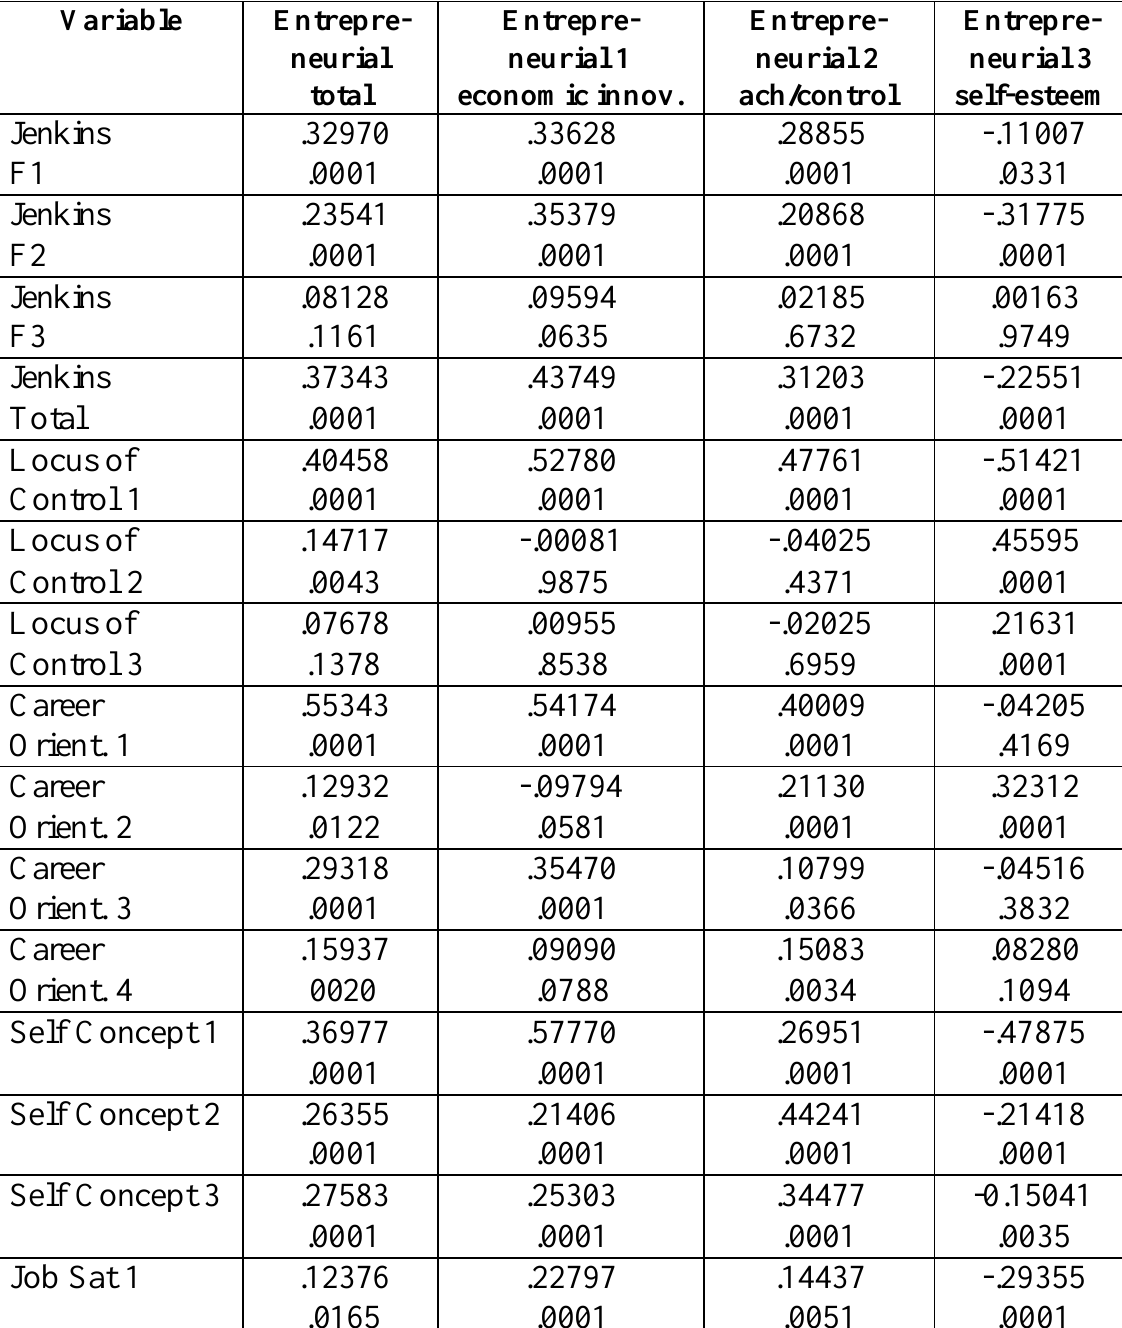
Table 5 Results from Pearson correlation coefficients of factor variables with entrepreneurial attitude for the total sample (N =